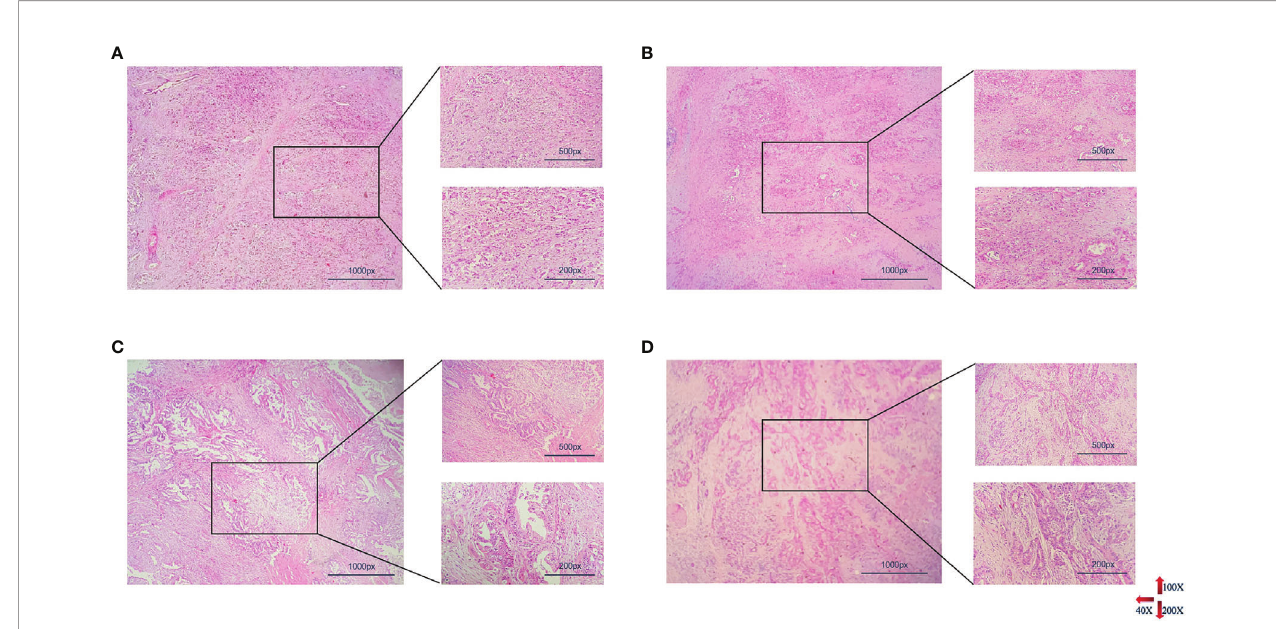
FIGURE 2 | Histopathological results of PDAC with different degrees of differentiation. From (A – D) represented poorly differentiation, moderately-poorly differentiation, moderately differentiation, highly-moderately differentiation respectively (PDAC, pancreatic ductal